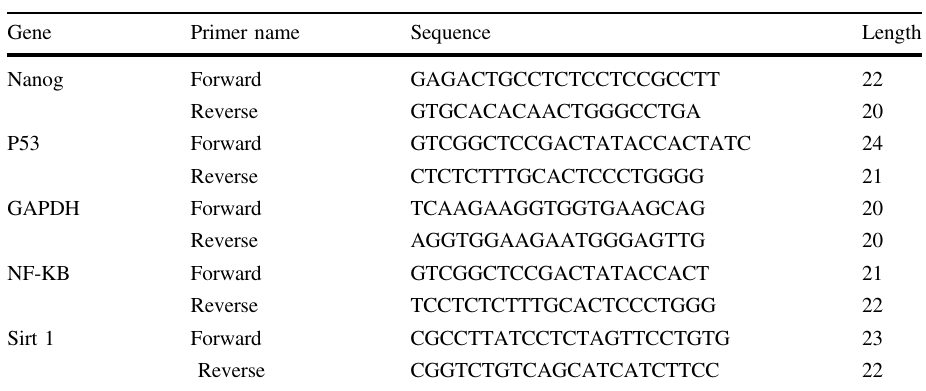
Table 1 Primer sequences of each